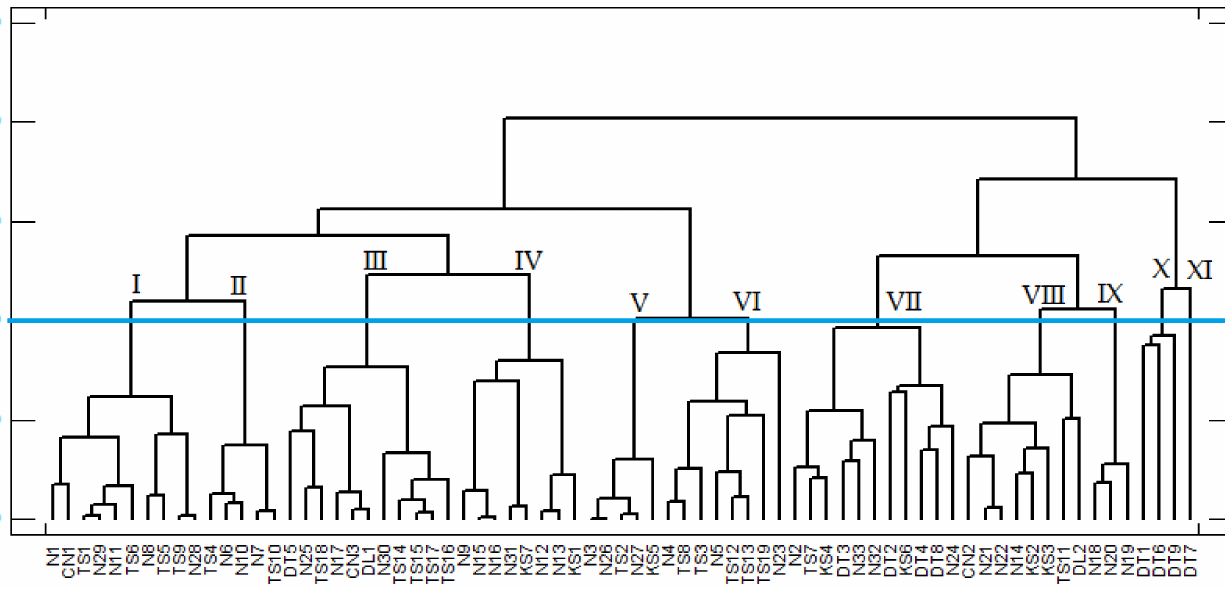
Figure 3. Clustering surface water quality in the study